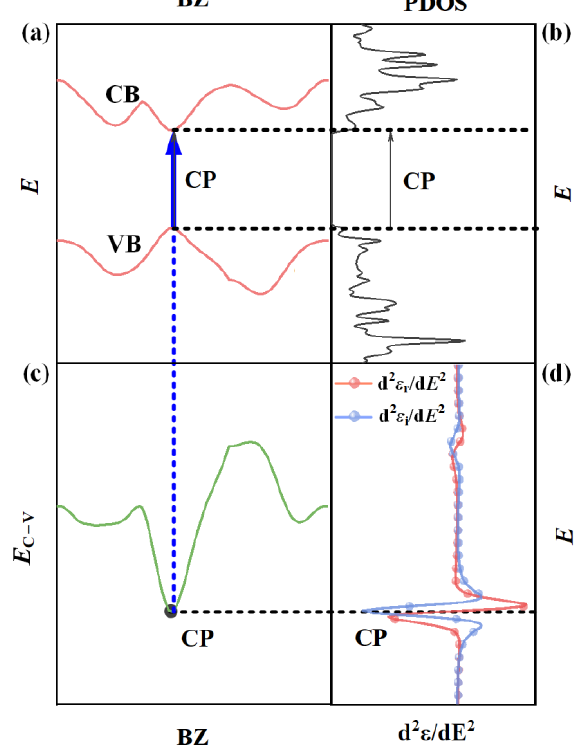
Figure 1. Scheme of the operating principle and procedures of the proposed method to identify the CP optical transitions of 2D materials based on the SE, CP analysis and first-principle calculations: ( a ) first-principle calculated band structure; ( b ) first-principle calculated partial density of states (PDOS); ( c ) differential band structure; ( d ) CP analysis results.